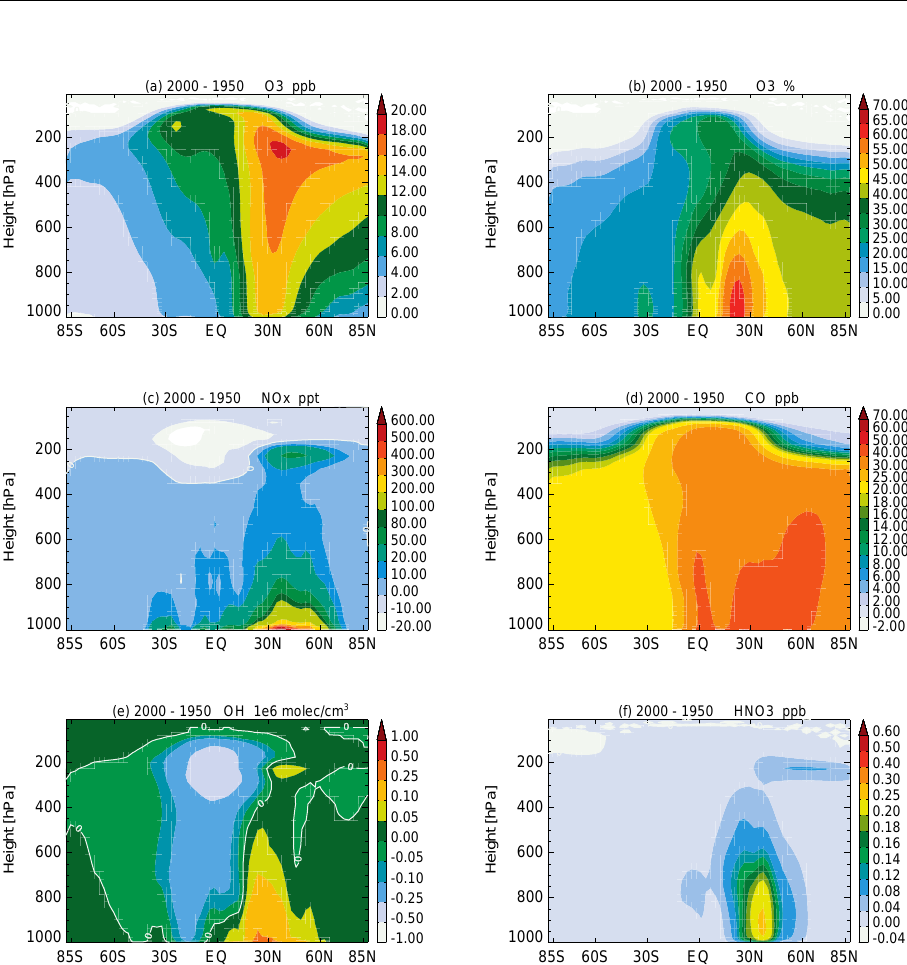
Fig. 2. The 2000–1950 difference in annual mean zonal concentration for O 3 absolute (a) , O 3 relative (%) (b) , NO x (c) , CO (d) , OH (e) and Figure 2: The 2000-1950 difference in annual mean zonal concentration for O 3 HNO 3 (f) absolute (a), O 3 relative (%) (b), NO x (c), CO (d), OH (e) and HNO 3 (f).